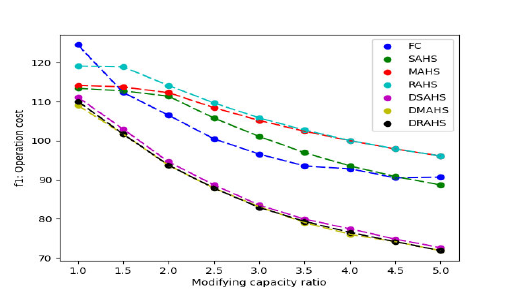
Fig. 6. The impact of capacity on 𝒇